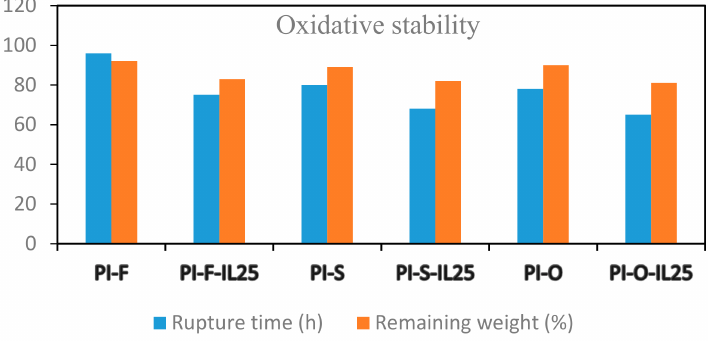
Figure 8. Oxidative stability of the pristine PIs and composed